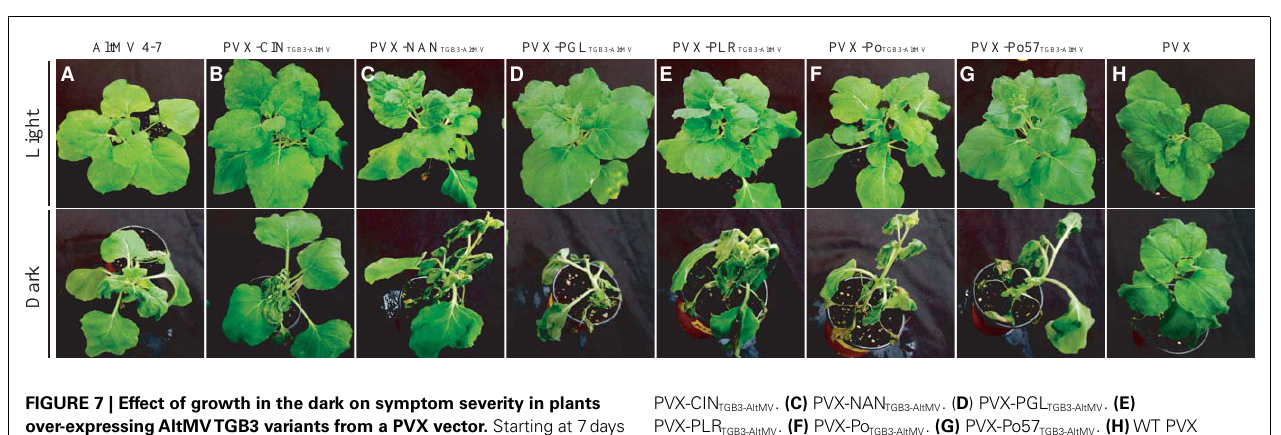
FIGURE 7 | Effect of growth in the dark on symptom severity in plants over-expressingAltMVTGB3 variants from a PVX vector. Starting at 7days after inoculation, N. benthamiana plants infected with AltMV 4–7,WT PVX, or PVX(TGB3 AltMV + ) variants were incubated for 6days under either diurnal light or constant dark conditions. Upper row – plants grown in light; Lower row – plants grown in dark. (A) AltMV 4–7 (positive control). (B)